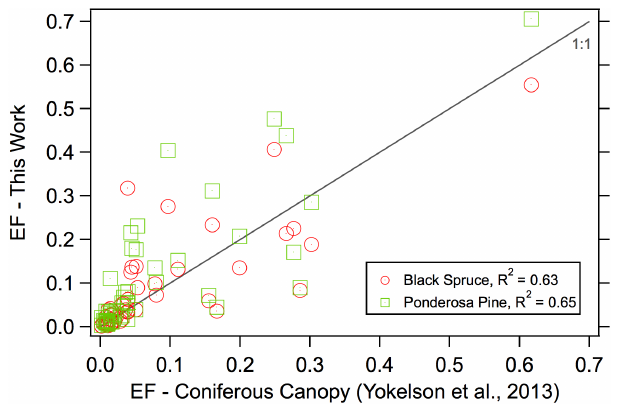
Figure 7. Comparison of the EFs measured for BS and PP, com- pared to the average of coniferous canopy burns given by Yokelson et al. (2013).